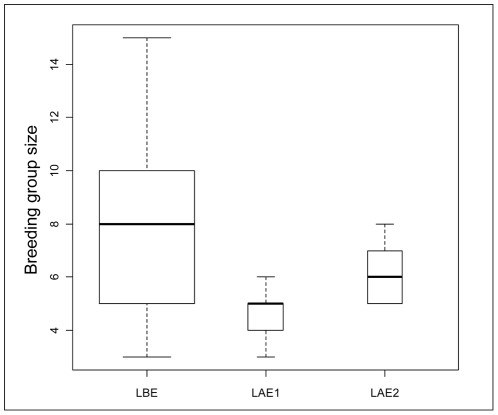
Boxplots of breeding group sizes during the study periods.LBE: Lokoué before Ebola, LAE1: Lokoué 2 years after Ebola, LAE2: Lokoué 6 years after Ebola (see details in Table 1). Bold horizontal lines are median values. The width of the boxes varies in proportion to the square roots of the number of observations in the groups. The ends of the vertical lines indicate the minimum and maximum values.